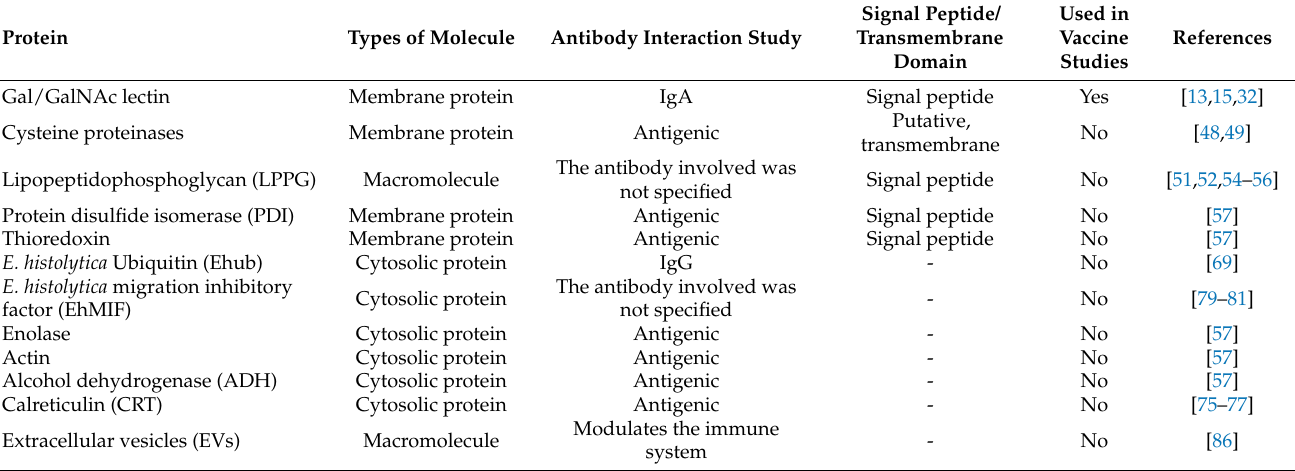
Table 1. Summary of the immune response interaction of biological membrane and non-membrane E. histolytica and their vaccination